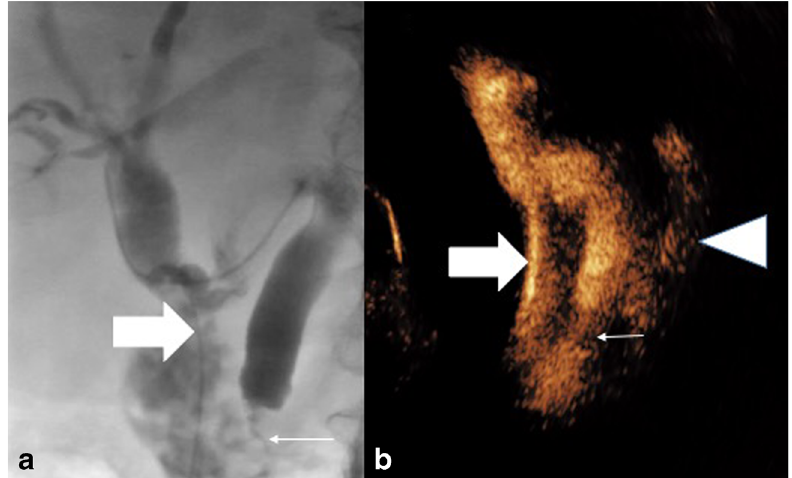
Fig. 4 (A) Conventional T-tube cholangiogram under fluoroscopy confirmed a stricture (arrow) but the leak was not seen. (B) Rotated image (for comparative purposes) of a CEUS cholangiogram administered via a T-tube (thick arrow), inserted post cholecystectomy. Ultrasound contrast delineates the common bile duct including a point of stricture (thin arrow) and a contrast extravasation leak